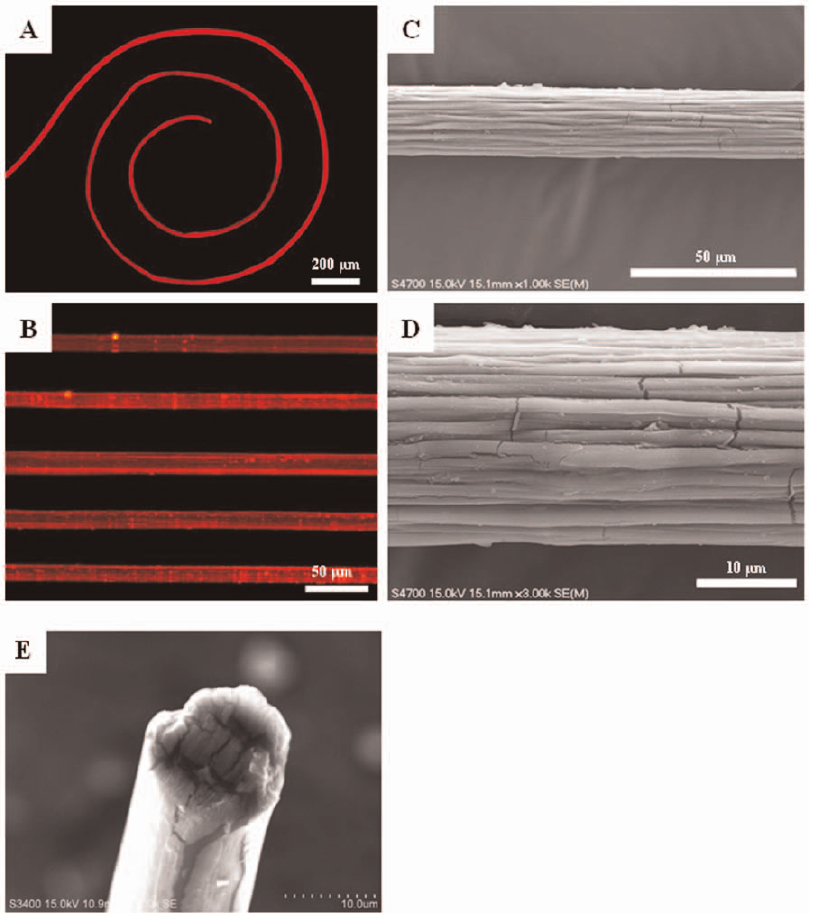
Figure 3. Microfiber images. Microscopic images (A , B, stained with Rhodamine B) and scanning electron microscopy images (C , E) of